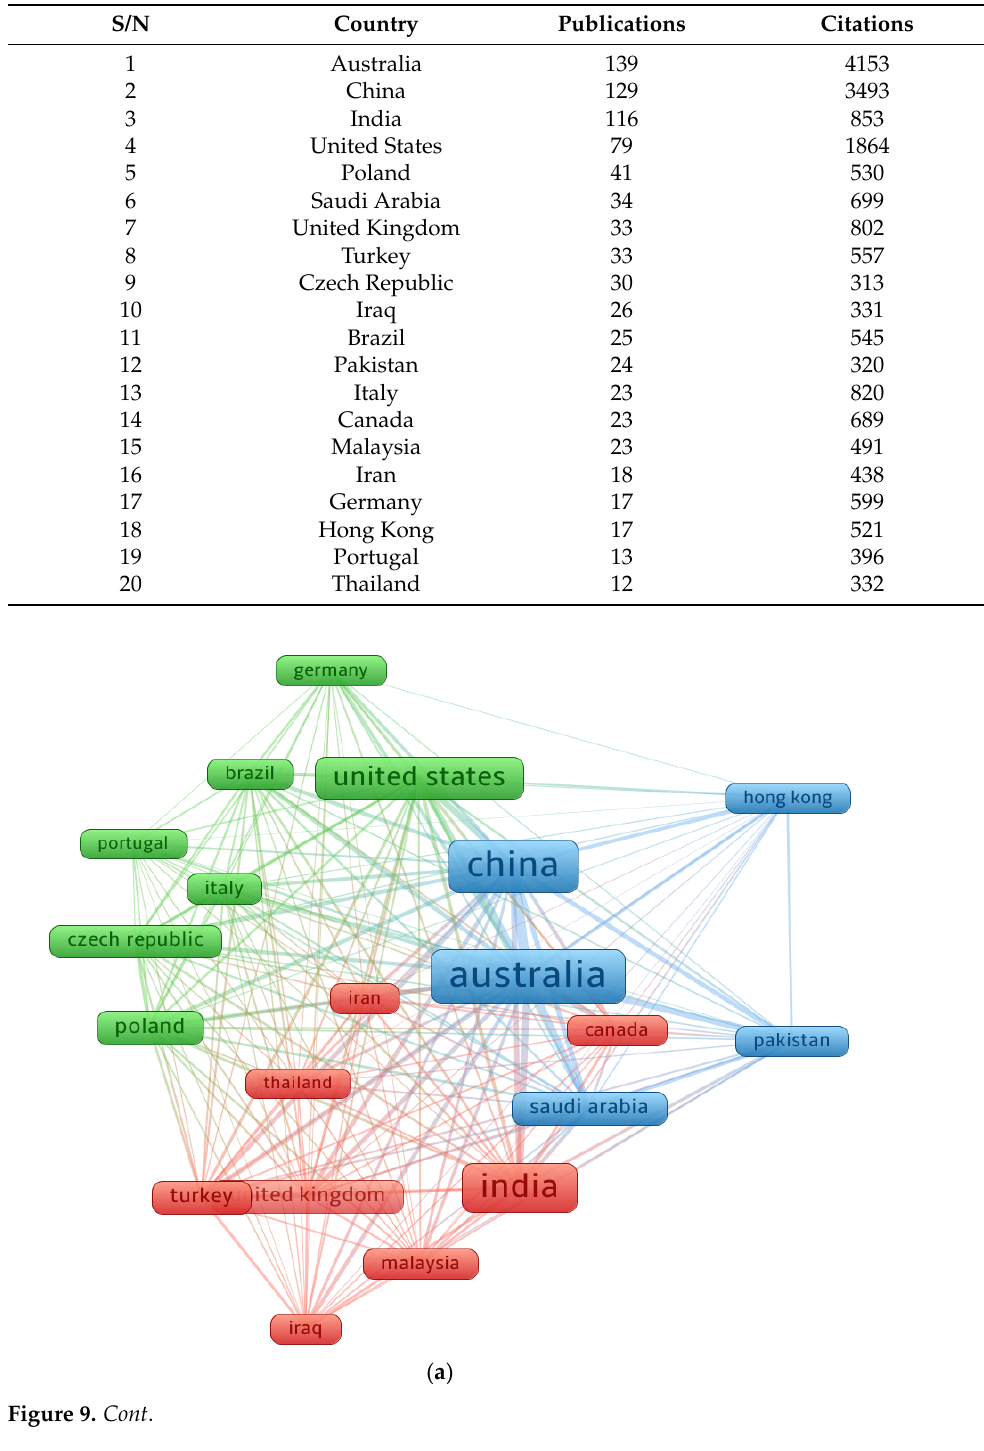
Table 5. Detail of regions actively devoted to FRGP investigations.